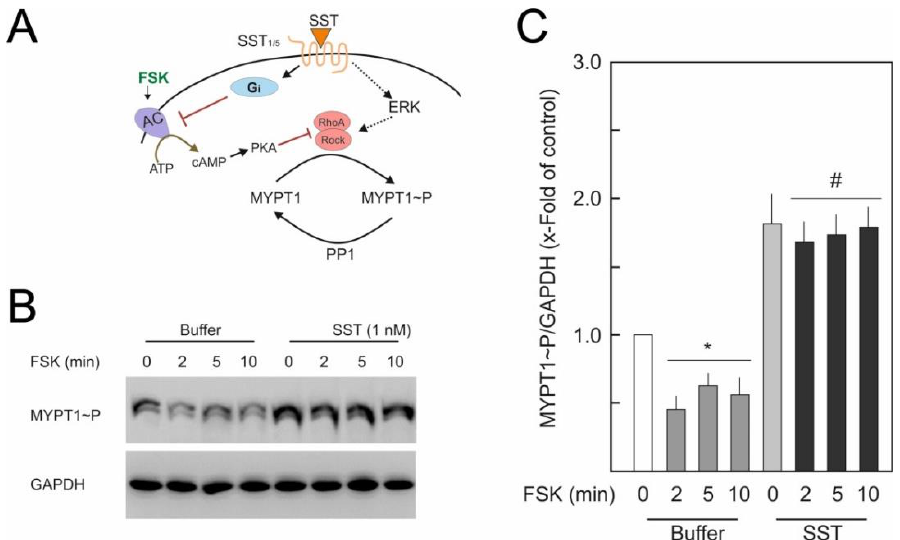
Figure 5. Effect of SST14 on cAMP/PKA-mediated inhibition of RhoA/Rock signalling. ( A ) Schematic presentation of FSK-mediated inhibition of RhoA/Rock signalling and the possible interaction with SSTR14 signalling. ( B ) HUVECs were treated with FSK (5 µ M) in the presence of buffer or SST14 (1 nM). Where indicated, cells were treated with U0126 (5 µ M) for 30 min before treating with SST and FSK. Representative Western blots of 3 experiments. ( C ) Quantification of blots from ( B ). p < 0.05; * vs. control, # vs. FSK